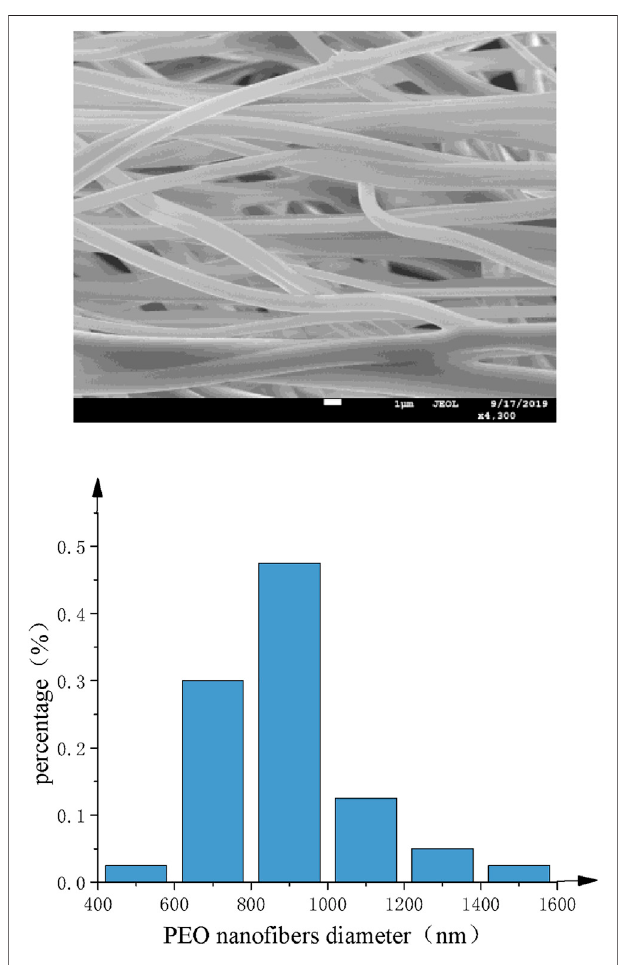
FIGURE 14 | Curved-tube nozzle. (A) SEM images of PEO nano fi bers. (B) Histogram of fi ber diameter